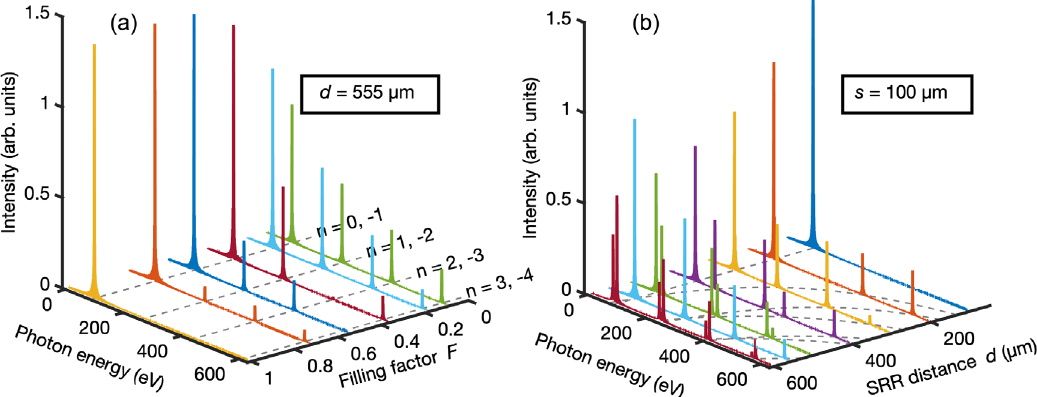
FIG. 5. Simulated on-axis spectra and the predicted photon energies based on the analytic model (gray dashed curves) for different filling factors (a) and distances (b). Geometries for six different filling factors (a) and for seven different SRR distances (b) were considered.